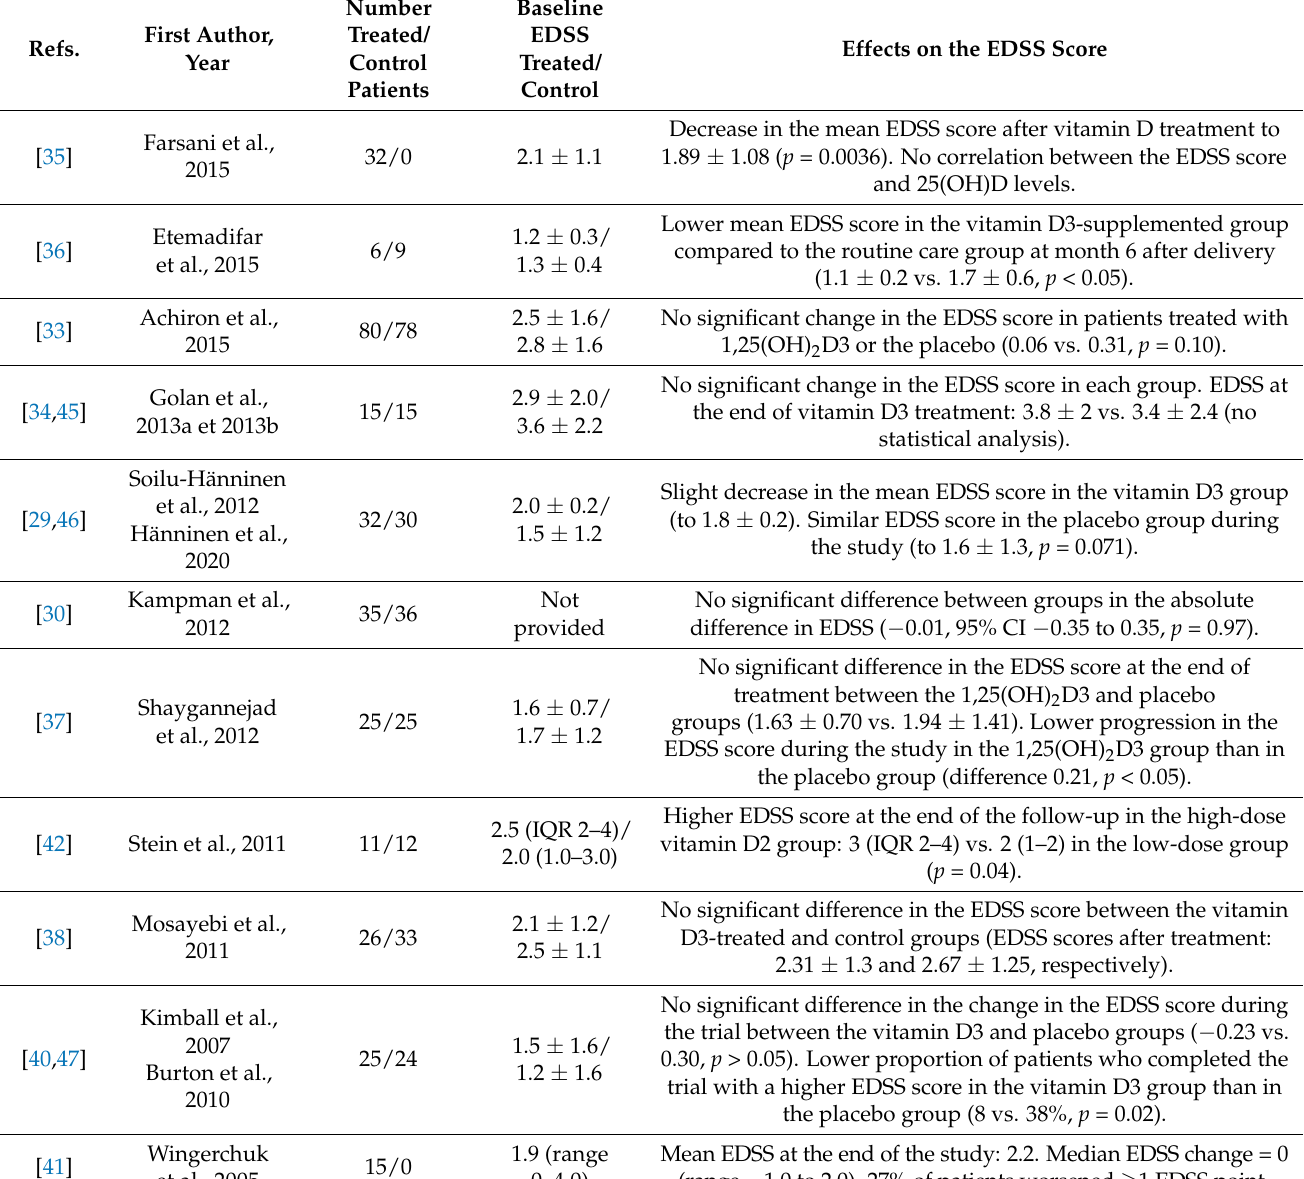
Five RCTs (corresponding to 132 vitamin D-treated and 133 control patients who completed the follow-up) reported that vitamin D had a beneficial effect on the EDSS score [23,29,36,37,40]. In the CHOLINE trial, the progression of the EDSS score was slower in the MS patients supplemented with vitamin D3 compared to those who received the placebo [23]. In the Finnish Vitamin D Study RCT, the EDSS score slightly decreased in vitamin D3-treated patients but not in the placebo group [29]. Shaygannejad et al. found a lower progression of the EDSS score in MS patients taking 1,25(OH) 2 D3 compared to the placebo [37]. Burton et al. observed no difference in the change in EDSS scores between the two groups, but the proportion of MS patients with a progression of the EDSS score was lower in the vitamin D3 group [40]. In addition, one trial showed that in 32 RRMS patients, the EDSS score significantly decreased after 8 weeks of vitamin D treatment, but without randomization against a control group